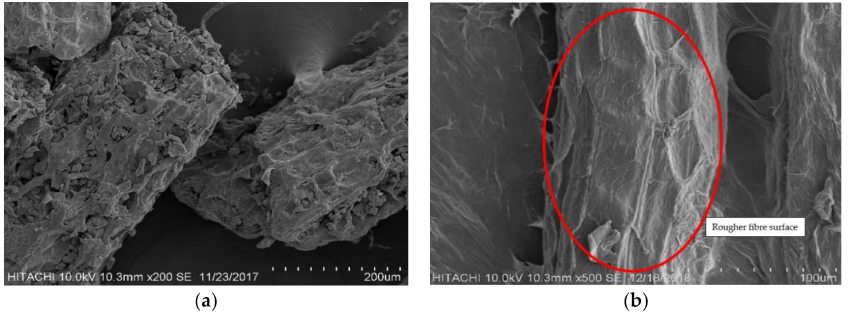
Figure 2. Scanning electron microscopy (SEM) micrograph for ( a ) unbleached jackfruit skin powder (JSP) and ( b ) bleached jackfruit skin powder (BJSP).